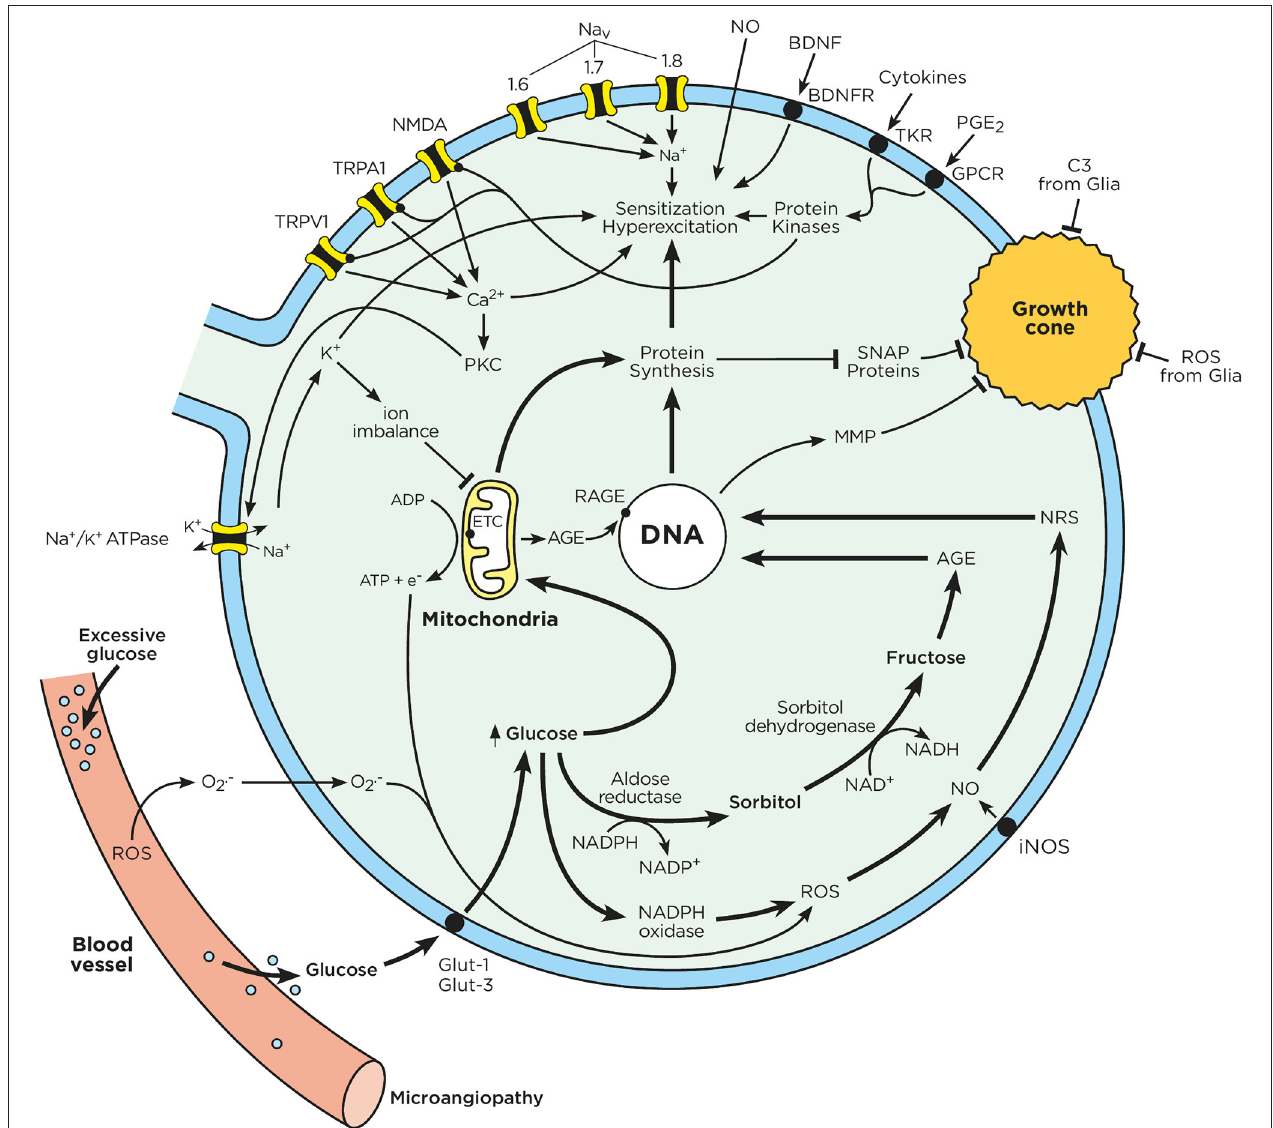
FIGURE 2 | Chronic hyperglycemia impairs neuron function. Sensory neurons have a limited capacity to regulate their uptake of glucose. In the context of chronic hyperglycemia, such as in diabetes, high glucose concentrations drive mitochondria to produce ATP and transfer electrons. Excess glucose is also metabolized through the polyol pathway, leading to the production of advanced glycation end products. The electrons from the mitochondrial respiratory chain combine with intracellular oxygen and nitric oxide to produce ROS and RNS. Consequently, RNS, ROS, and AGE activate nuclear transcription factors, which enhance the expression of ion channel transducers (TRP and Na V channels) in addition to impairing neurons’ capacity to self-repair. At the same time, microglia-released mediators (cytokines, ATP, BDNF, NO) stimulate GPCR and tyrosine kinase receptors, triggering downstream signaling cascades, which lead to the phosphorylation of TRP and Na V channels. A decrease in the activation threshold of these ion channel transducers can augment the influx of cations, which ultimately results in action potential firing and ectopic discharges. These effects enhance pain perception and signaling to the CNS. Chronic hyperglycemia also increases oxidative stress in the blood vessels that supply oxygen and nutrients to neuron terminals. This oxidative stress can cause microangiopathy, a phenomenon characterized by the loss of capillaries, which starves neuronal energy supplies. These phenomena are responsible for the loss of neuron terminals and pain insensitivity, as typically observed in later stage of